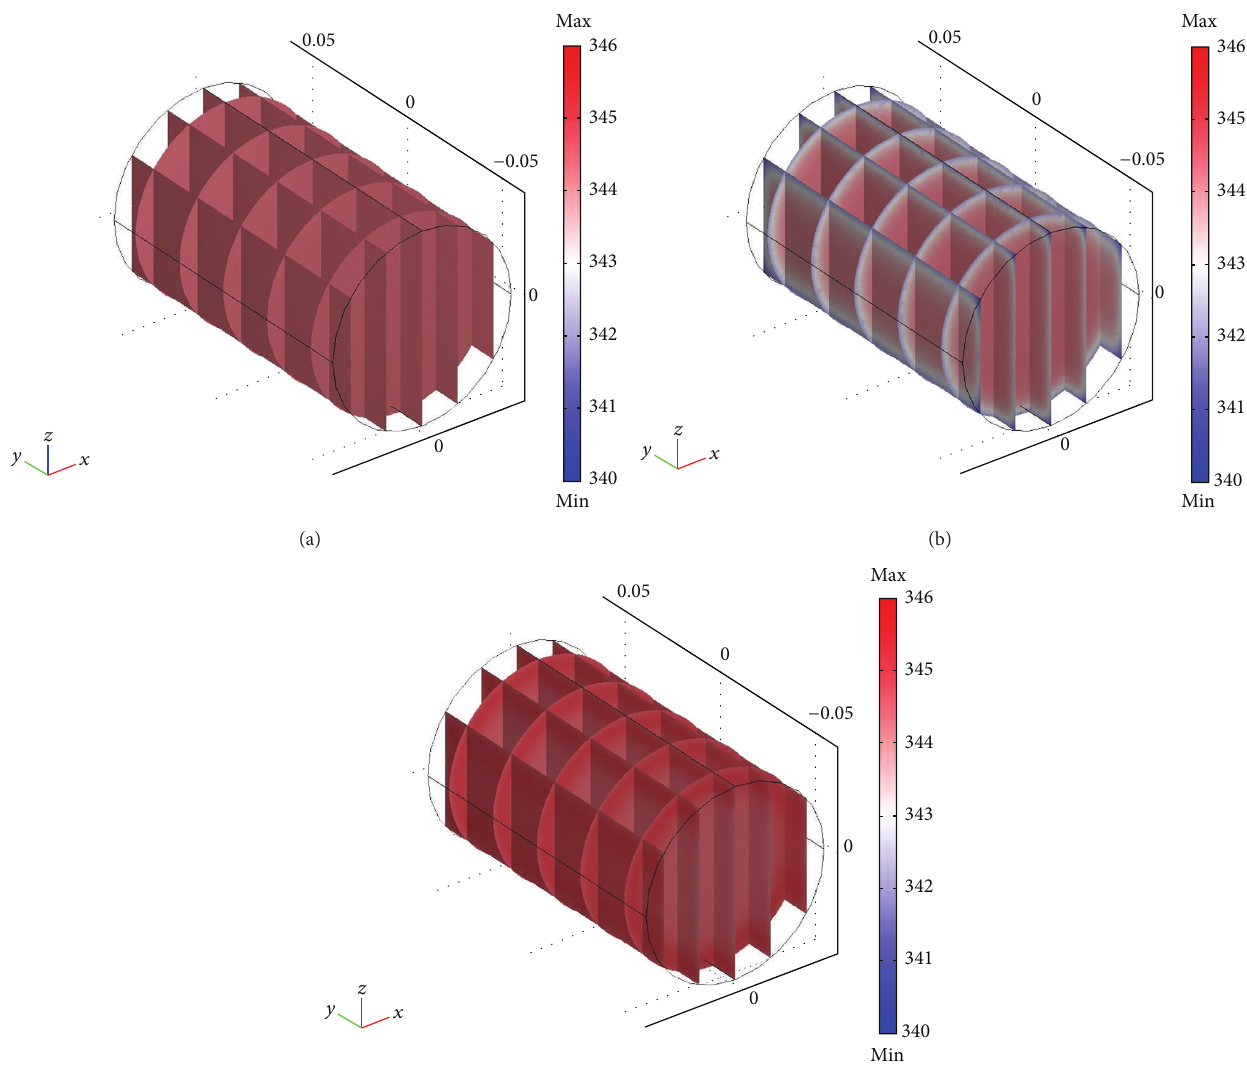
Figure 4: Slice plots representing temperature after 150 seconds of OH: applied voltage set point: 100V; 𝑇 0 = 279.15 K; 𝑈 = 0 Wm −2 K −1 (a); = 286.15 K (b) and 𝑇 = 314.15 K 𝑈 = 5 Wm −2 K −1 ((b) and (c)) 𝑇 inf inf